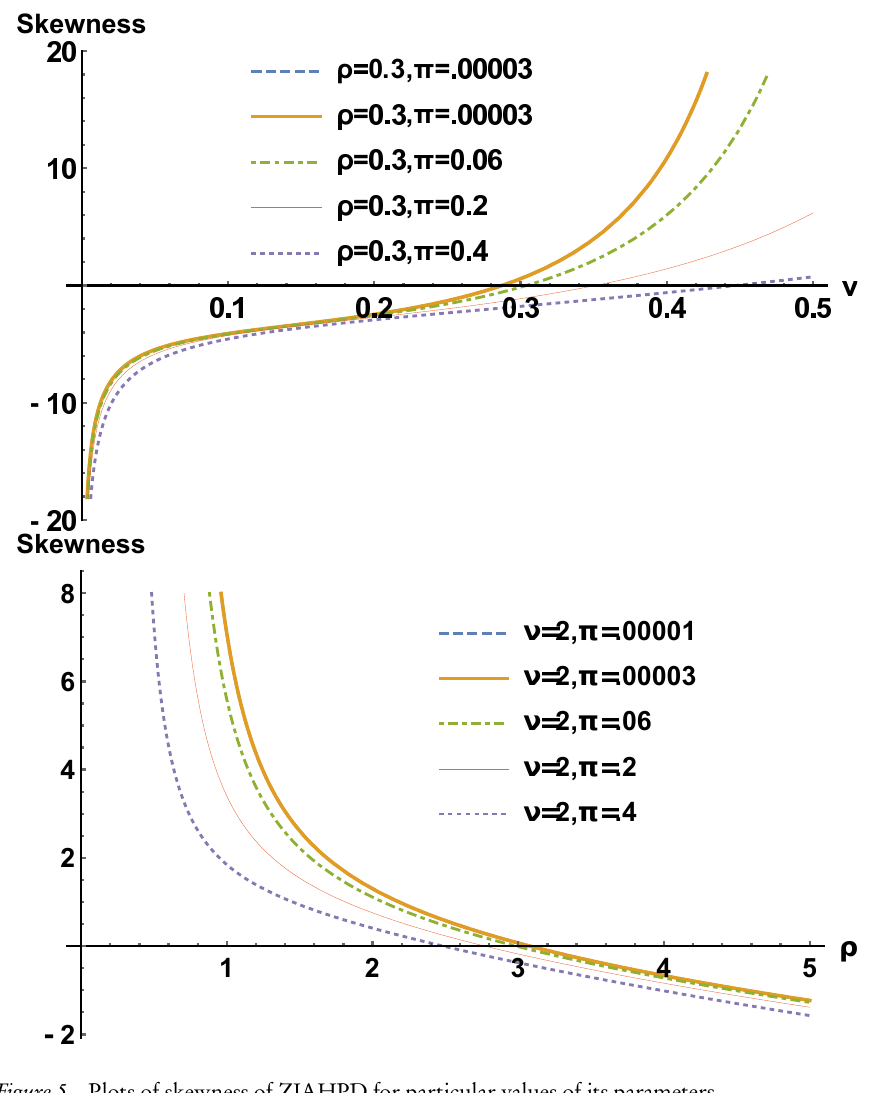
Figure 5 – Plots of skewness of ZIAHPD for particular values of its parameters.